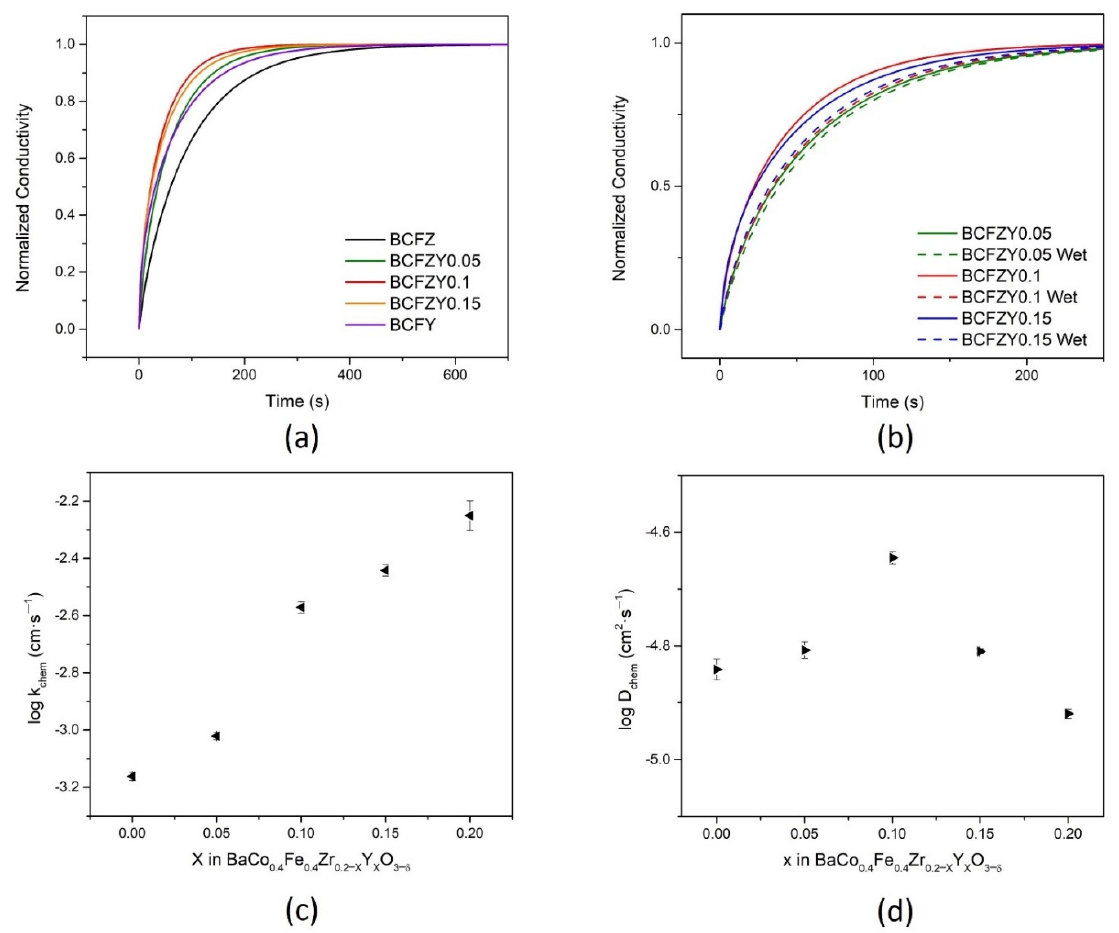
Figure 6. Electrical conductivity relaxation curves at 600 °C. For ( a ) BCFZY X samples and ( b ) BCFZY0.05, BCFZY0.1, and BCFZY0.15 under wet and dry atmospheres; the fitted dry atmosphere curves yield the ( c ) surface exchange coefficient, k chem , and ( d ) bulk diffusion coefficient, D chem .